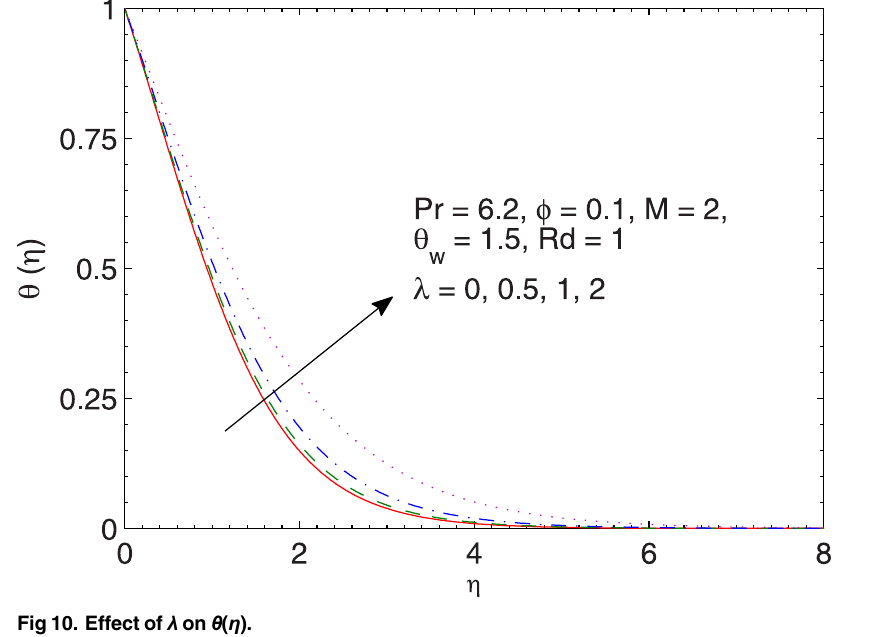
Fig 10. Effect of λ on θ ( η